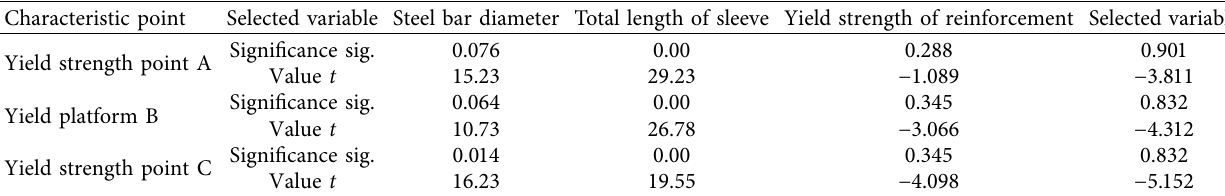
Table 3: The characteristic points significance analysis of strain.